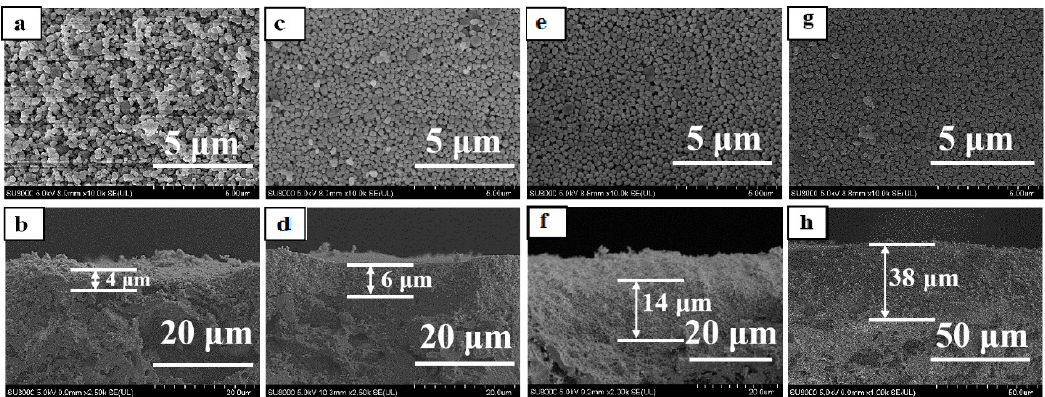
Figure 7. Surface and cross sectional images of seeded support with different seeded crystals concentration suspension (Z-3). ( a,b ) 2%; ( c,d ) 3%; ( e,f ) 5%; ( g,h ) 7%.